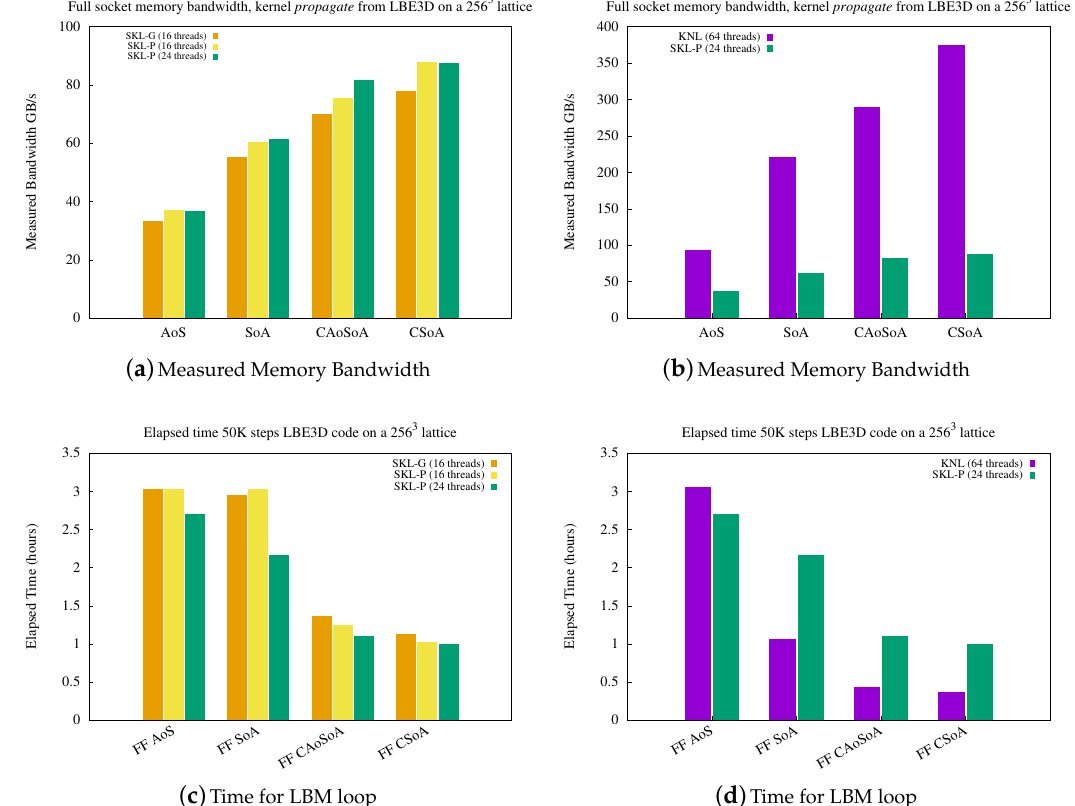
Figure 4. We report compute performance value of the optimized data layouts measured on both the SKL and the KNL processors. ( a ) reports the data related to the memory bandwidth measure with the propagate kernel on the SKL Gold 6230 and the SKL Platinum 8160. To emphasise the level of memory bandwidth saturation for the SKL Platinum 8160 we also report the numbers obtained using only 16 threads of the 24 available on socket. A comparison of the performance of memory bandwidth between the SKL and the KNL processor is reported in ( b ). ( c , d ) compare the performance, in terms of time to solution (full LB loop), of the three processors for the most optimized version of the LBE3D. Memory bandwidth (GB/s), kernel propagate on a 256 3 lattice